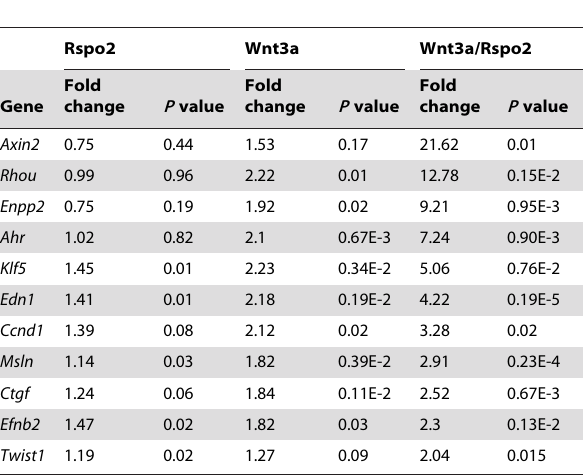
Fold change relative to level in cells treated with BSA.